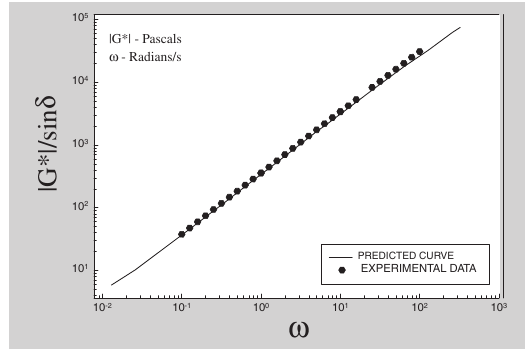
Figure 8 (left): Unified curve of the SHRP parameter |G*|/sin d with modified fre- quency w (L1/n/MVR) at temperatures of 46˚C - 70˚C for unmodified original unaged asphalts. Figure 9 (right): Comparison of the predicted curve and experimental data for the SHRP parameter |G*|/sin d with frequency w at temper- ature of 52˚C for unmodi- fied original unaged asphalt who are modeling the performance of